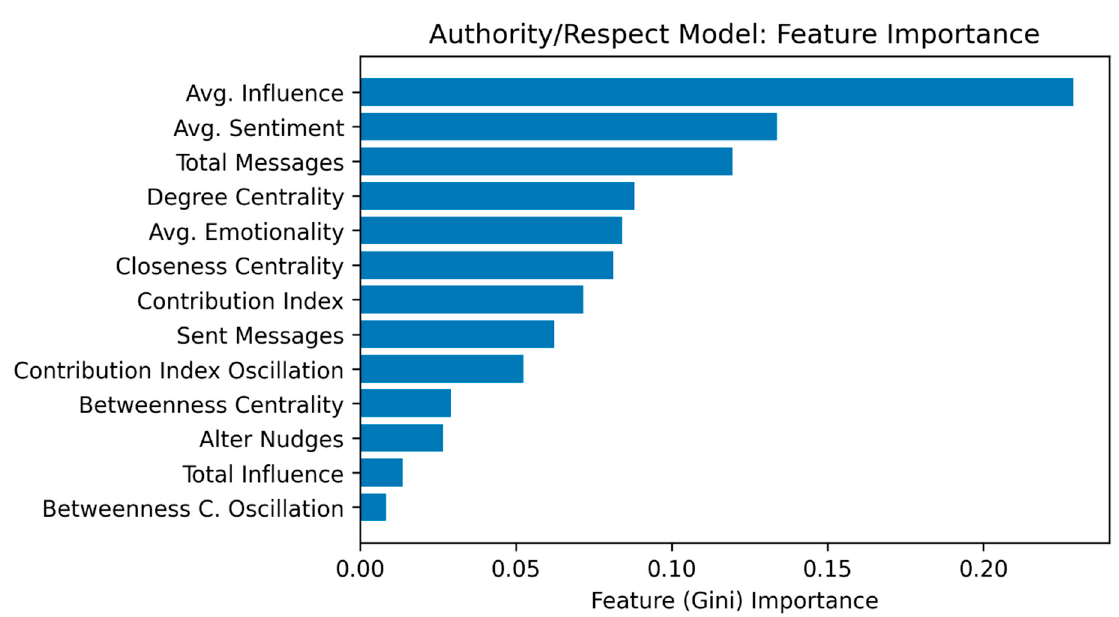
Figure 4. Feature Importance of Authority/Respect Model.